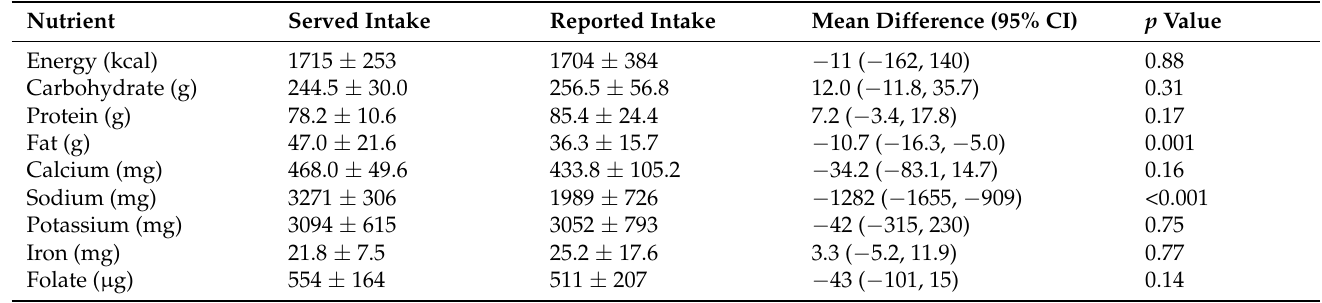
Table 5. Mean ( ± SD) values of served and reported intakes of energy and select nutrients among older Korean women ( n = 22) 1